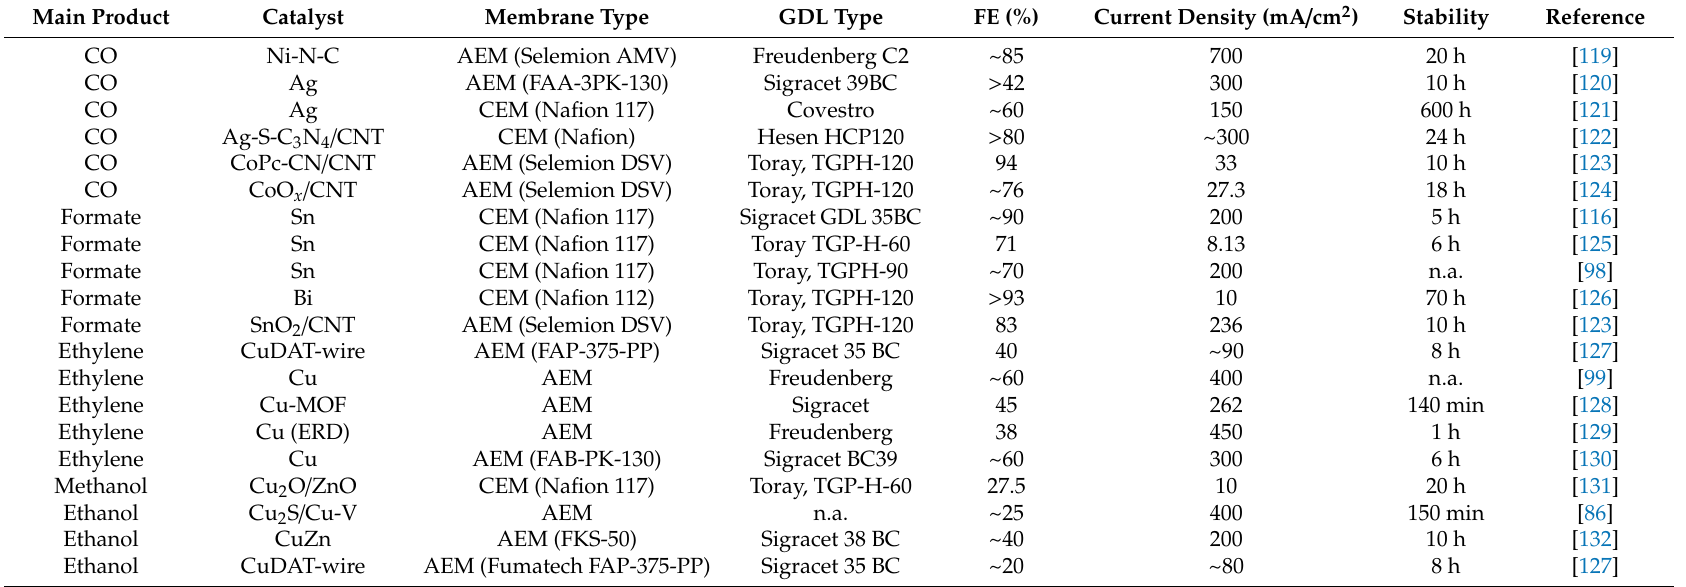
Table 1. A list of CO 2 conversion performance using basic gas-fed flow electrolysers. AEM: anion-exchange membrane, CEM: cation-exchange membrane, CNT: carbon nanotubes, ~: